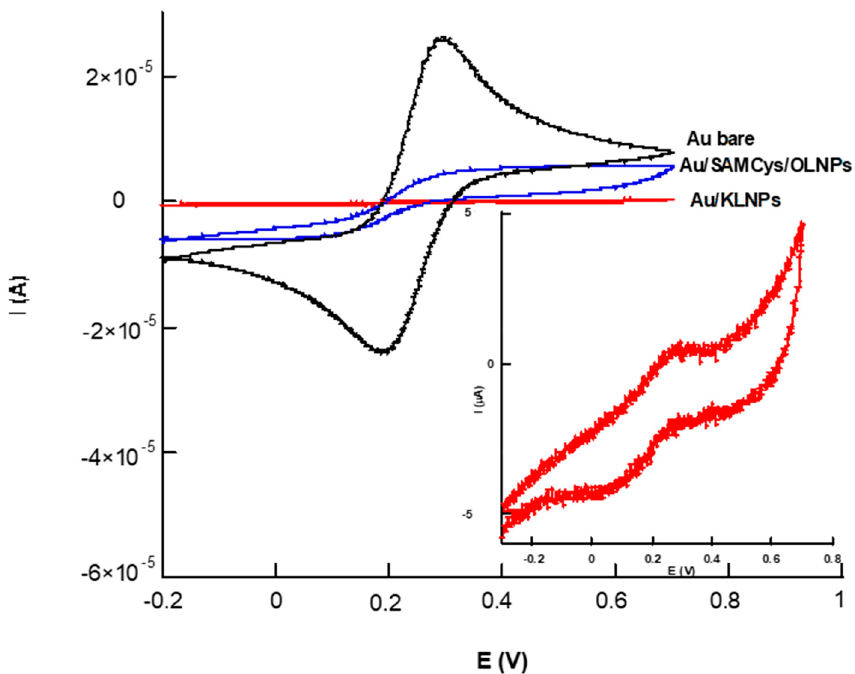
Figure 2. Cyclic voltammetry of 1.1 mM K 3 [Fe(CN) 6 in PBS buffer on Au bare (black line), Au/SAMCys/OLNPs (blue line) and Au/KLNPs (red line), at ν = 100 mV s − 1 . In the inset, a magnification of the red curve.